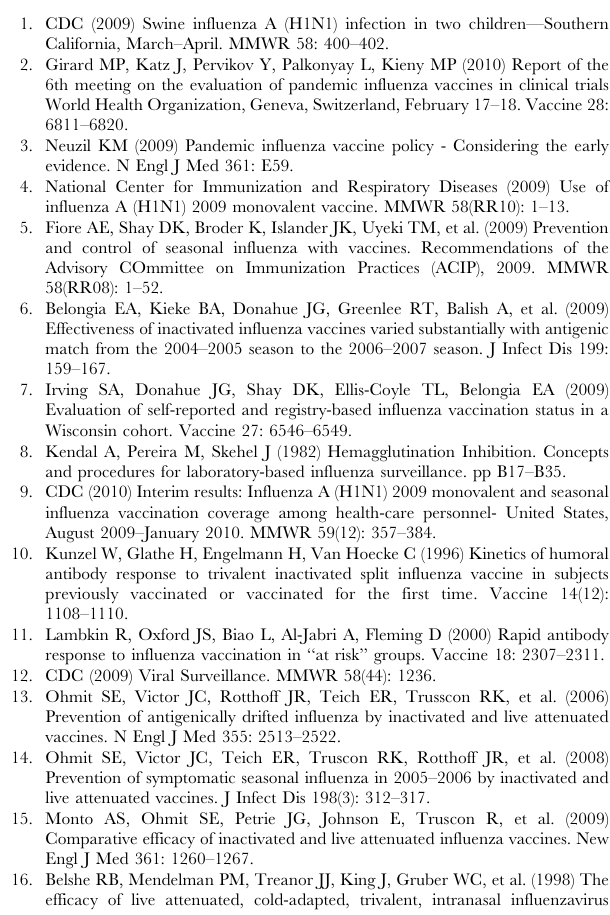
Table S1 Percent Vaccinated more than 14 Days Prior to Illness Onset by Case Control Status and Adjusted Vaccine Effectiveness (alternate model), by Age Group and Vaccine